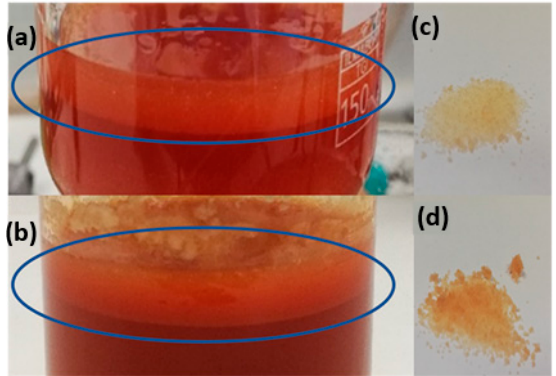
Figure 2. Examples of emulsions—( a ) Sample 2 and ( b ) Sample 3—and washed wax colloidosomes of ( c ) Sample 2 and ( d ) Sample 3. The emulsion phase is circled in panels ( a , b ).